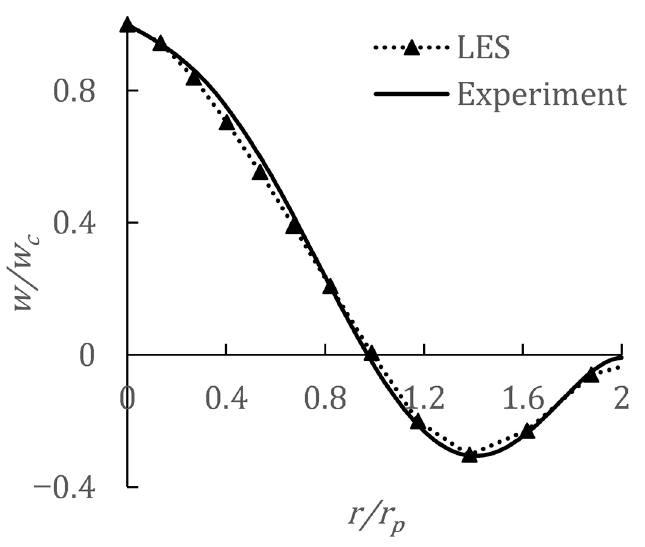
Figure 11. Comparison of present large eddy simulation (LES) data with vertical velocity profile of jet at the pycnocline by Ezhova and Troitskaya.